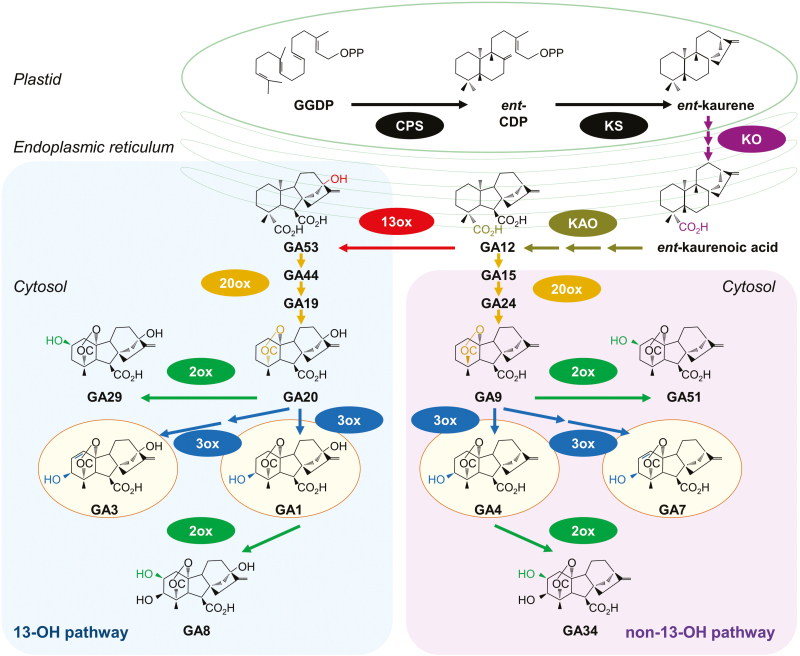
Metabolic pathways leading to active GA biosynthesis. Modified redrawn from Hedden and Thomas (2012) and Yamaguchi (2008). The active forms of GA are in yellow ovals; the GA oxidase enzymes are abbreviated as 13ox, 2ox, and 3ox. The enzymes ent-copalyl diphosphate synthase (CPS), ent-kaurene synthase (KS), ent-kaurene oxidase (KO), and ent-kaurenoic acid (KAO) are indicated, together with the metabolites geranylgeranyl diphosphate (GGDP) and ent-copalyl diphosphate (ent-CP). The primary breakdown products of the active GA1 and GA4 forms are also shown (GA8 and GA34). The coloured bonds and atoms in the chemical structures indicate the modifications catalysed by the enzyme shown in the same colour (Yamaguchi, 2008). Isoform numbers are not included, as they appear to be distributed spatially rather than segregating between the two pathways (Suzuki et al., 2005). Note that some oxidized C-20 intermediates might not be released by the enzymes during some of the multistep reactions (Hedden and Sponsel, 2015). Recently, Liu et al. (2019) showed that a 2-oxoglutarate-dependent dioxygenase catalysed the formation of a previously unknown, biologically active gibberellin (DHGA12) in seeds of Arabidopsis thaliana, by hydration of GA12.